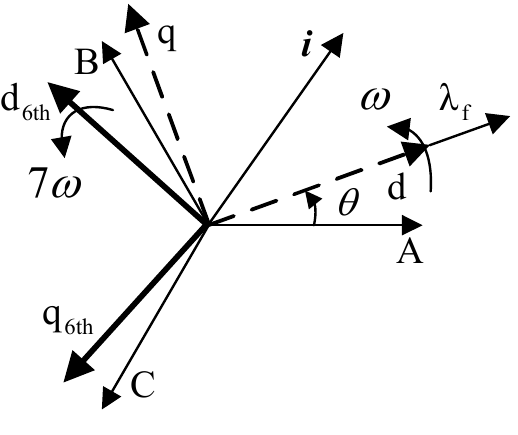
12 of 25 Figure 9 . Block diagram of the 6th-order harmonic suppression. PI: proportional–integral. The feedback loop of the harmonic suppression requires the 6th-order harmonics to be transformed to DC, the error between the command value and the estimated one is the input of the